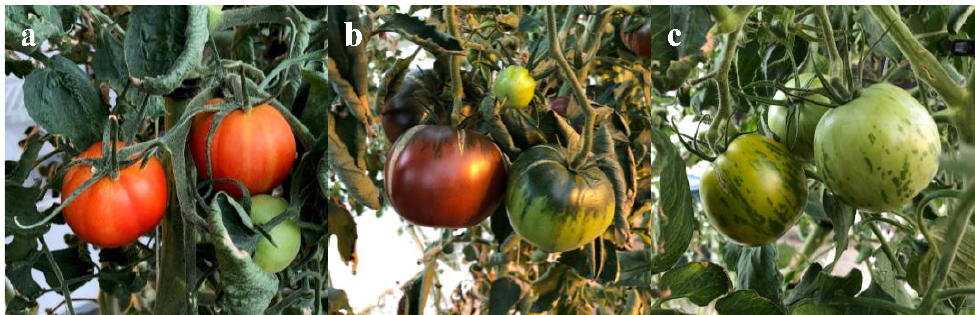
Figure 1. Standard (Big beef) and heirloom (Black Krim and Green Zebra) scions were grafted onto WT (self-graft), Arnold, or Supernatural rootstocks. Plants were grown in hydroponic culture at the Western Illinois University School of Agriculture Greenhouse facility, Macomb, IL. ( a ) Big Beef. ( b ) Black Krim. ( c ) Green